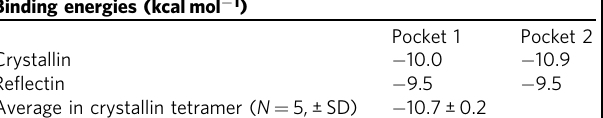
Table 1 Calculated binding energies of Xa with chromatophore